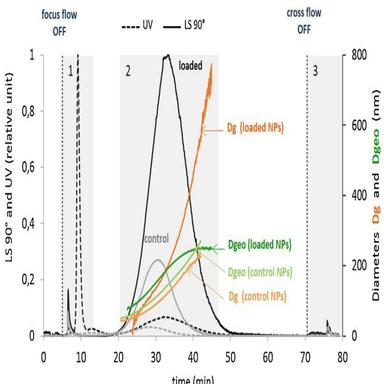
AF4–UV(dotted line)–MALS (solid line)fractogramobtained for loaded (in black) and control(in grey)formulations in the optimized conditions (Vinj =50 -L;membrane RC 10 kD; mobile phase SDS 0.1% w/v). Calculated gyration diameters Dg (orange lines) and geometric diameters Dgeo (green lines) are also given. (For interpretation of the references to colour in this figure legend, the reader is referred to the web version of this article.)